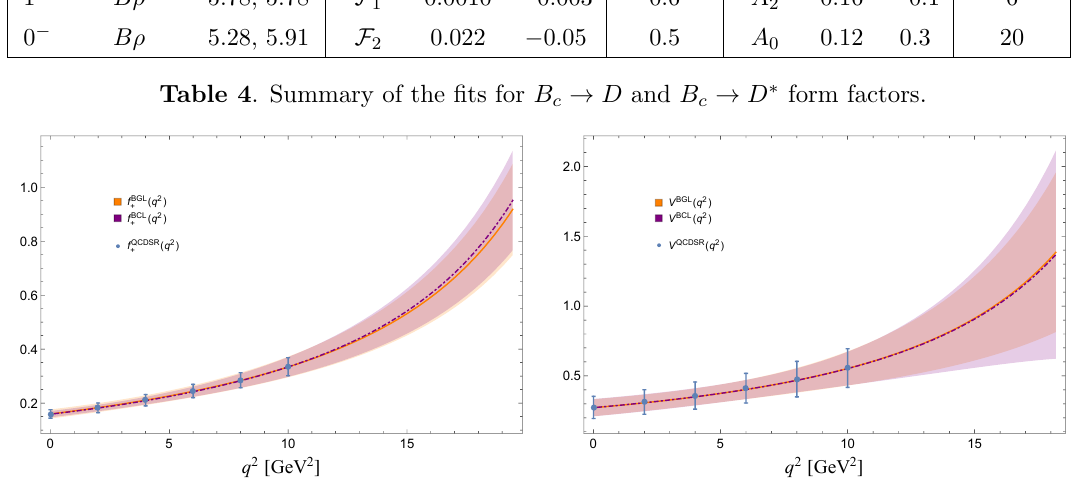
Figure 2 . The BGL (purple, dot-dashed line) and BCL (orange, full line) (cid:12)ts to the QCDSR values of f + ( q 2 ) and V ( q 2